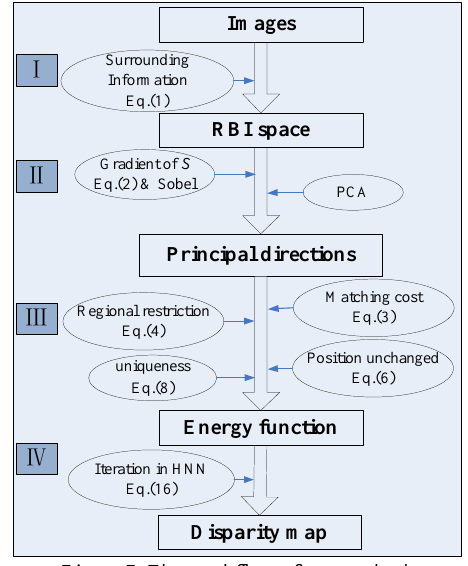
Figure 7. The workflow of our